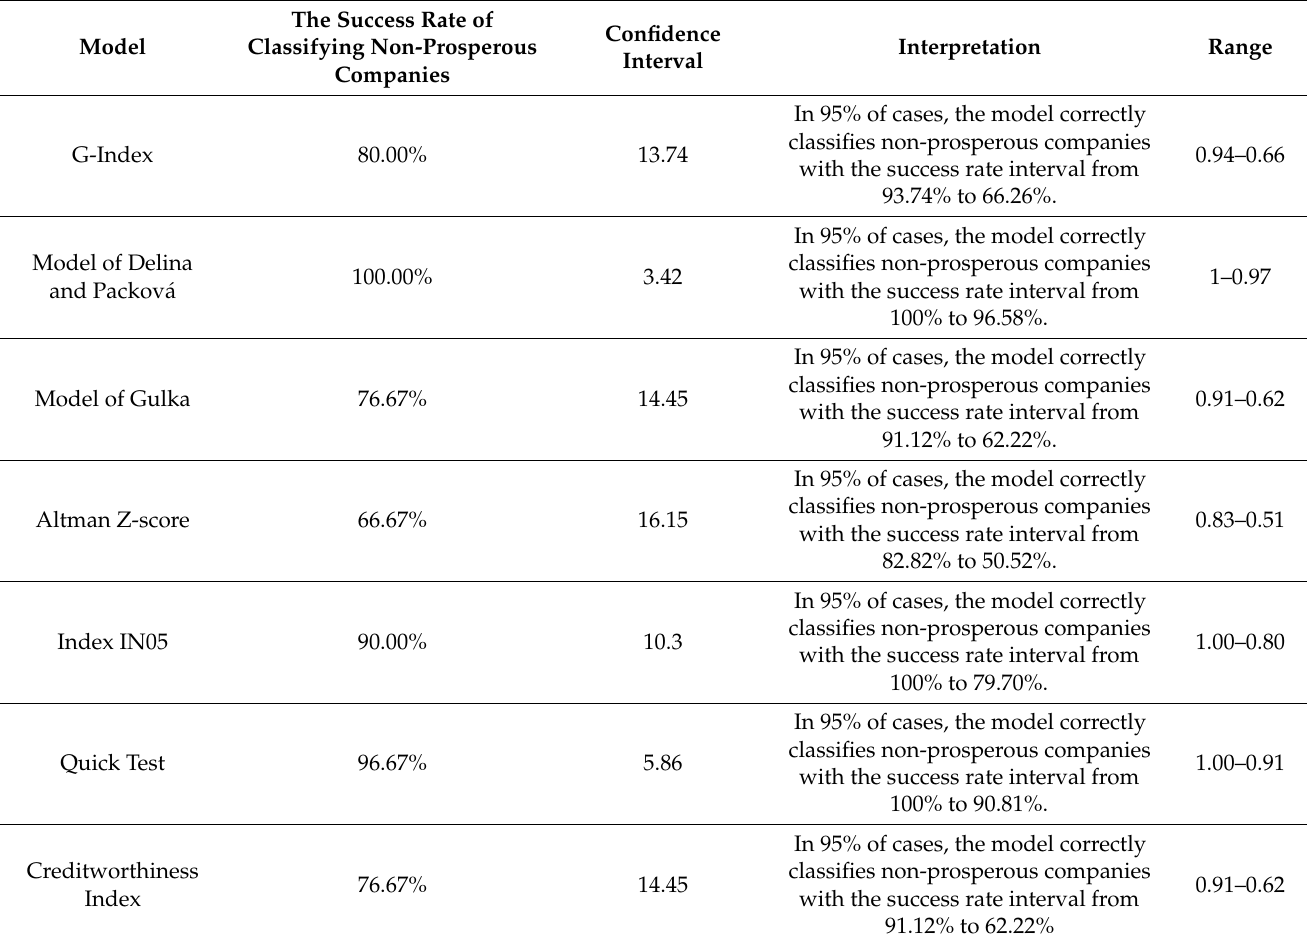
Table 11. Confidence interval of correctly classifying non-prosperous companies for each default prediction model according to type I error rate,